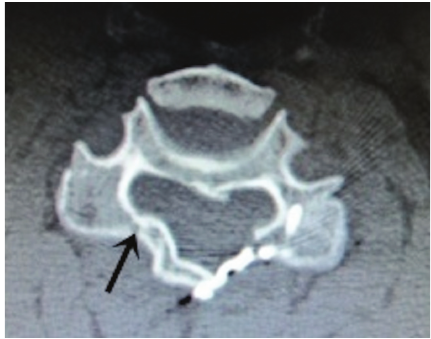
Figure 5: The hinge was perfectly formed continuously only at the ventral cortex that immediately appeared after surgery (arrow) that may cause a false positive on interpretation.